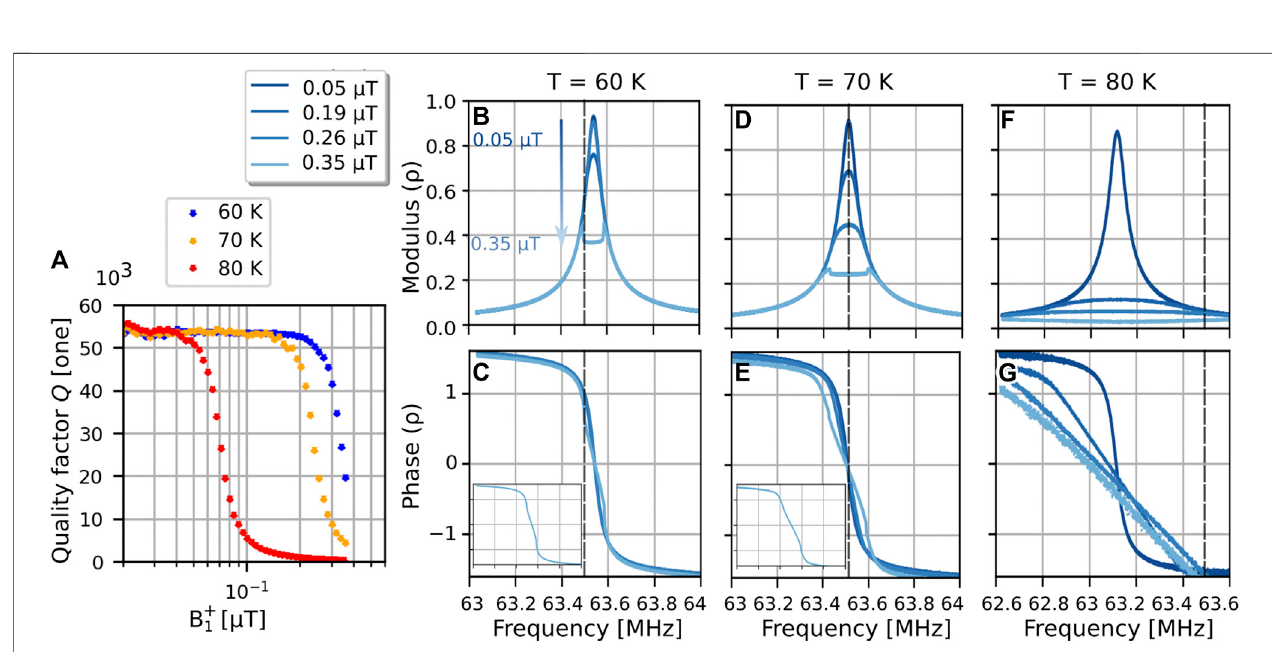
FIGURE6| (Setup 1) – (A) Measuredqualityfactor Q oftheHTS coilasafunctionoftheRFmagnetic fi eld B 1 fordifferenttemperatures and (B – G) swept-frequency analysis of the nonlinear HTS coil for different temperatures and B 1 . The top (B,D,F) and bottom (C,E,G) rows respectively display the modulus and phase of the compensated re fl ection coef fi cient ρ comp . The dashed line at 63.5 MHz provides a visual guideline to highlight the temperature drift of the resonance frequency. The insets in (C) and (E) highlight the phase discontinuity observed for B 1 (cid:2) 0 . 35 μ T.